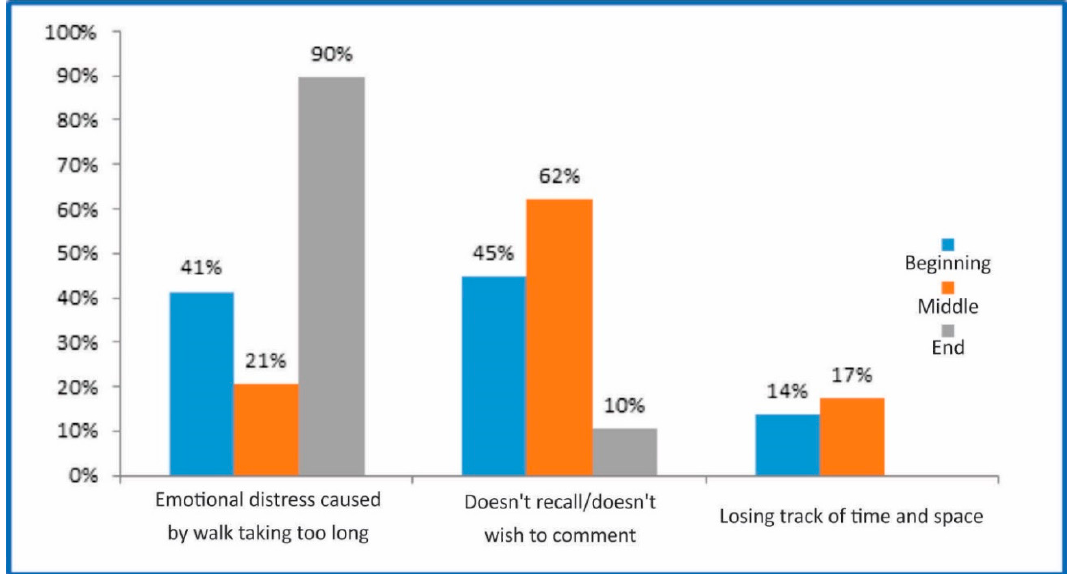
Figure 1. Correlation with time and space: perception and sensation.